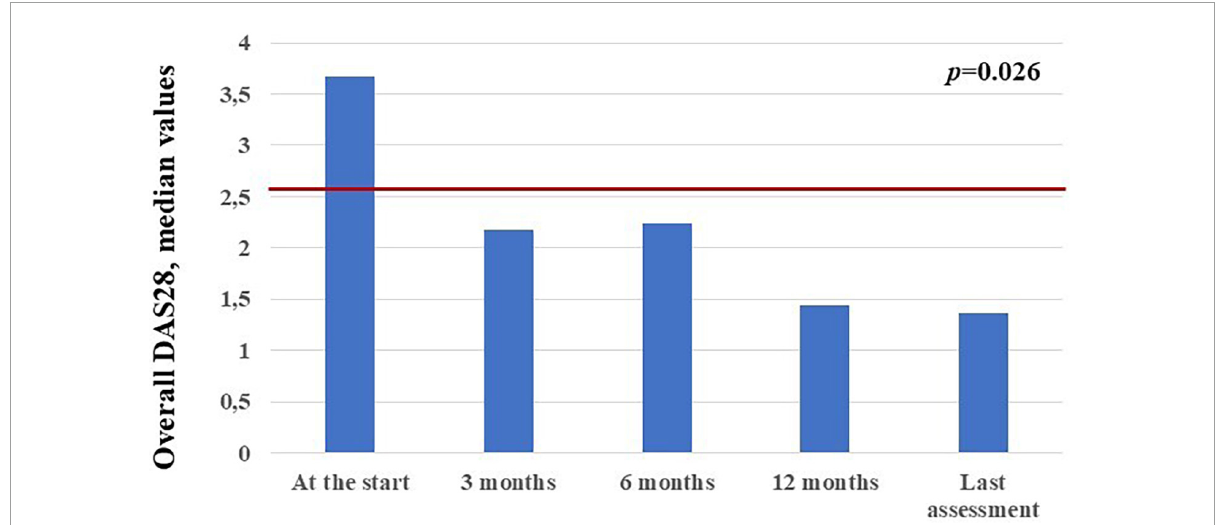
FIGURE7 Median DAS28 values observed in the 14 patients with arthritis at the different time points. The red horizontal line indicates the DAS28 threshold below which arthritis may be considered in